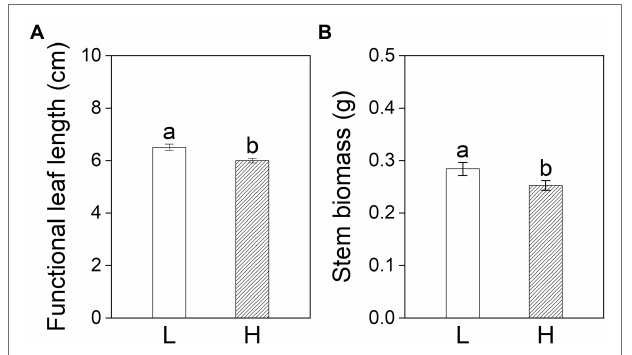
FIGURE 5 | Functional leaf length (A) and stem biomass (B) of P. hydropiper from low (L) and high (H) elevations on day 20. Different lowercase letters represent significant differences between two